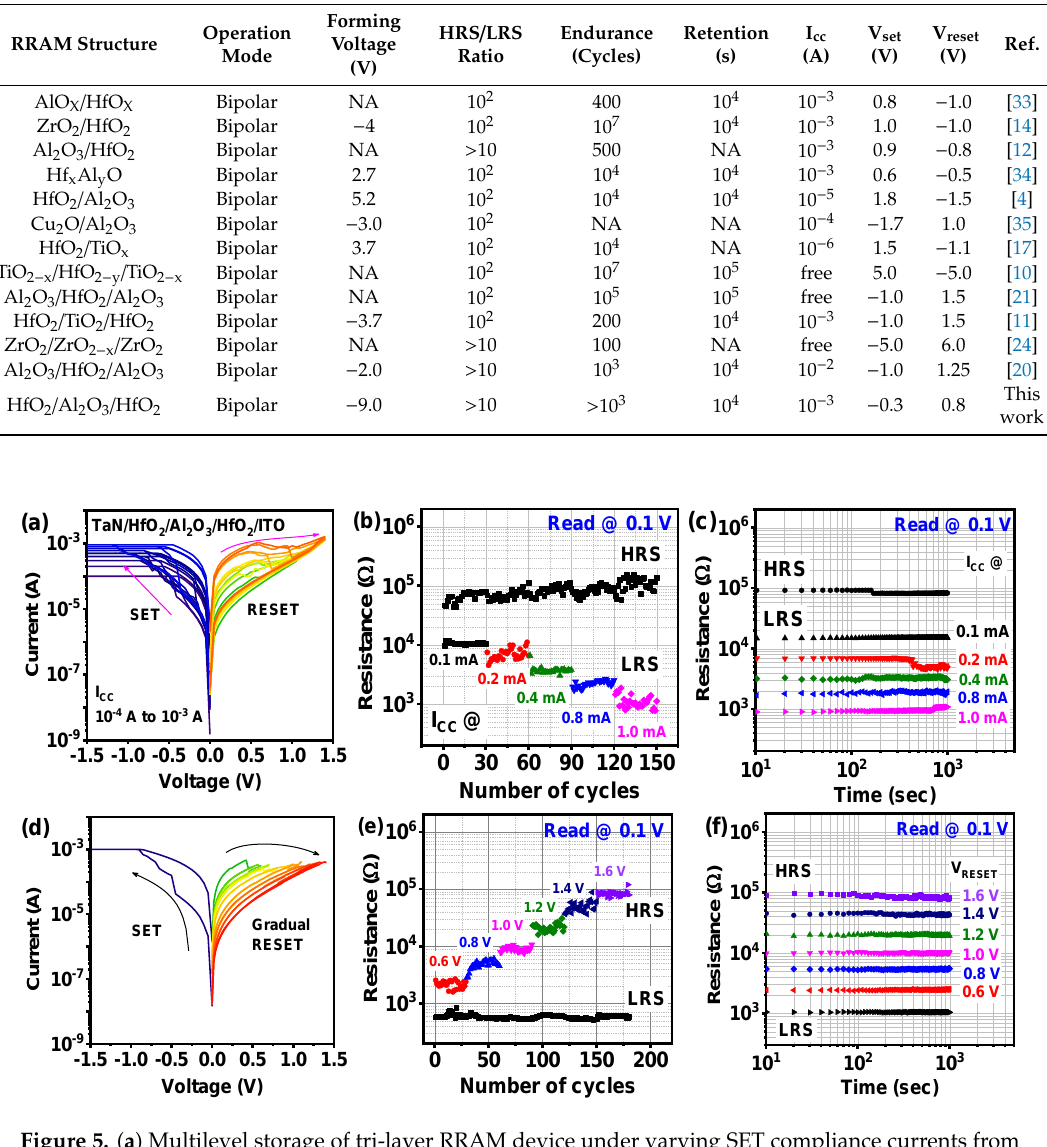
Table 1. Comparison of electrical parameters for di ff erent RRAM structures.